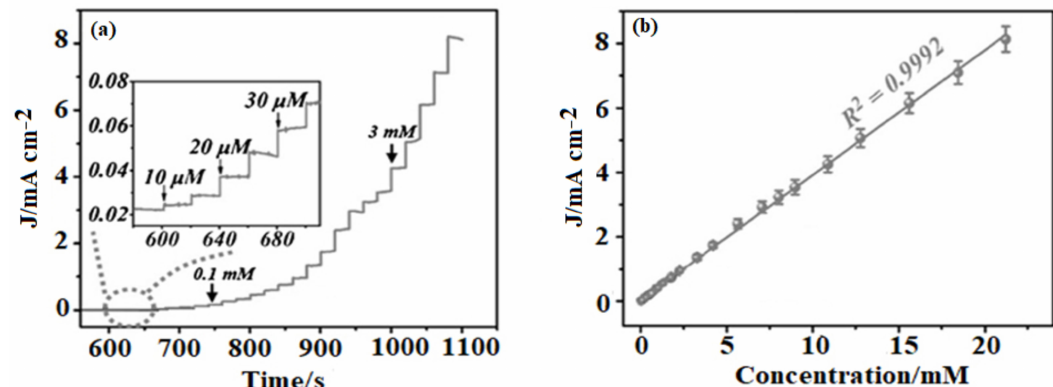
Figure 4. ( a ) The amperometric responses of the CuCo 2 O 4 NWs-pPy@CCE at 0.45 V toward successive glucose addition to a 0.1 M NaOH solution; Inset: The enlarged response for the marked area. ( b ) The related calibration